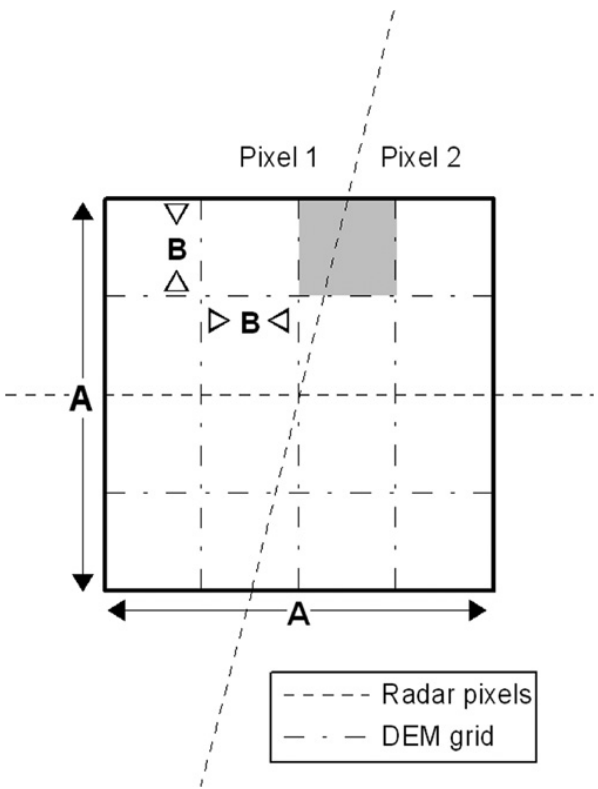
Fig. 8. Superposition of radar pixels over DEM grid over a small domain of area A 2 . The highlighted grey DEM grid pixel is used as example of mismatching between the two